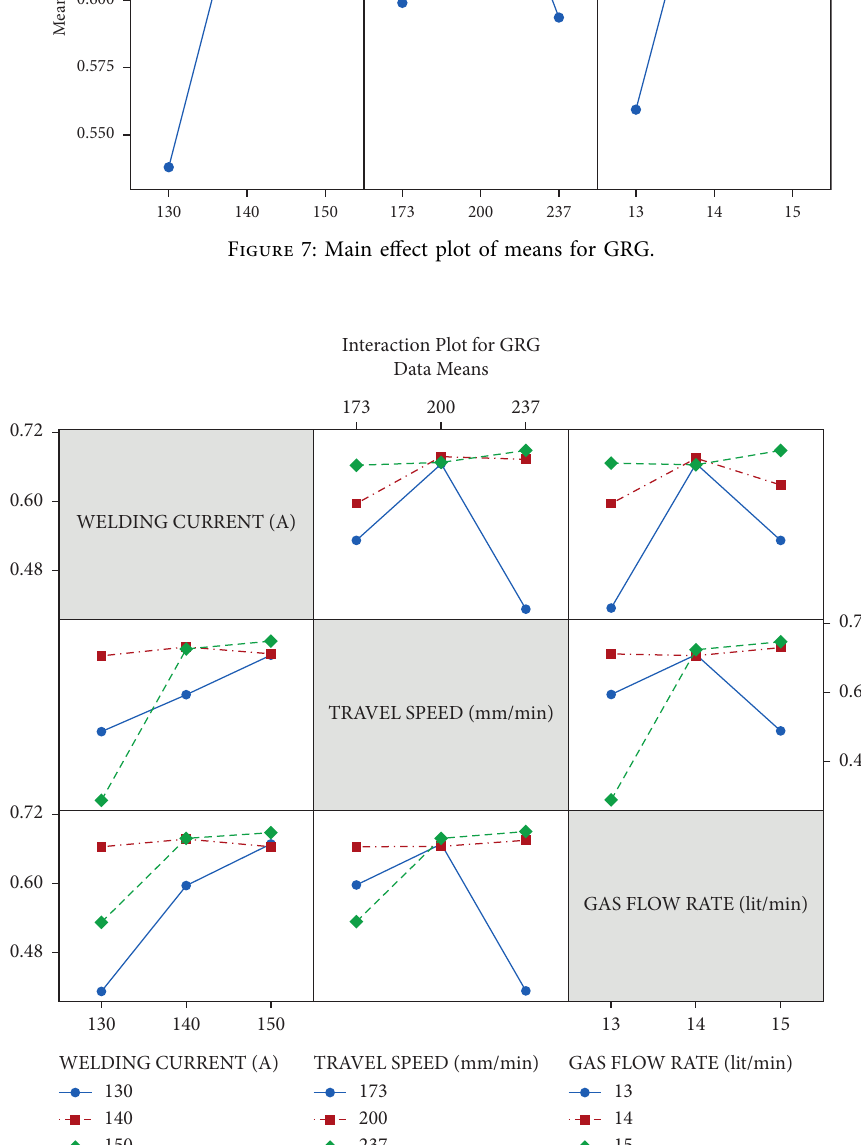
Figure 8: Interaction plot for